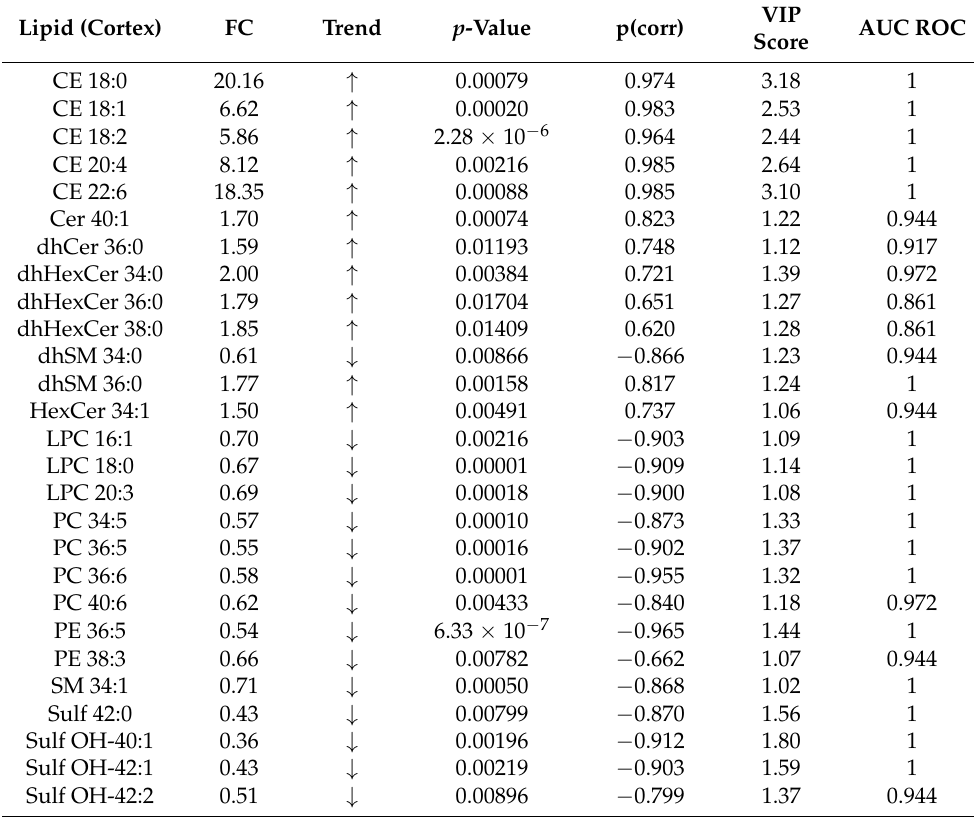
Table 2. Selected cortex lipids, which are potential biomarkers of cisplatin-induced renal damage. The CISPL group was compared with the CNT group. FC: fold change. p -values from univariate analysis are considered. Areas under the curve (AUC) from the receiver operating characteristic curve (ROC) are included. Lipids with p -value < 0.05, FDR < 0.1; |p(corr)| > 0.5 and VIP score > 1 from the OPLS-DA model are